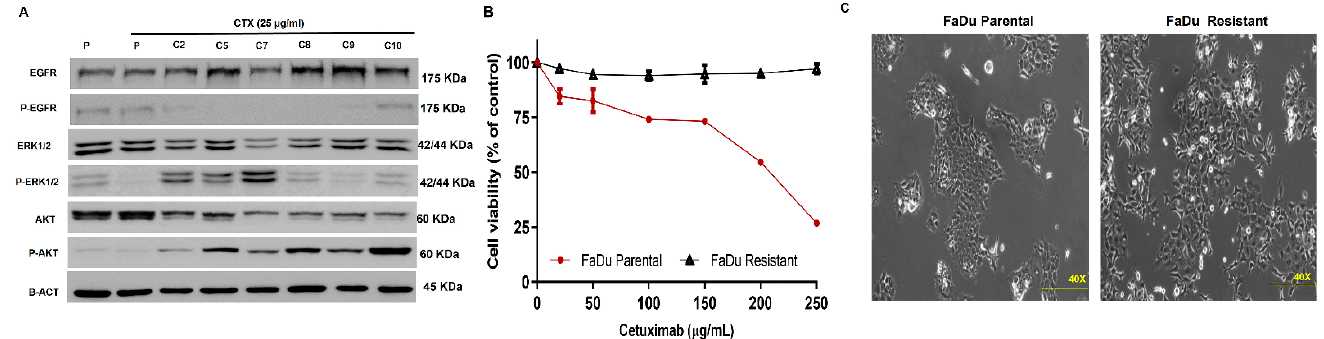
Figure 1. Cetuximab resistant model establishment and characterization. ( A ) EGFR signaling of parental and cetuximab-resistant clones after cetuximab resistant model establishment. ( B ) Cell viability assay of parental and resistant clone upon cetuximab exposition in 72 h. ( C ) Cell morphology of parental and resistant cells P: FaDu parental; R: FaDu resistant; C: Clone. The images were acquired in 10× magnification.